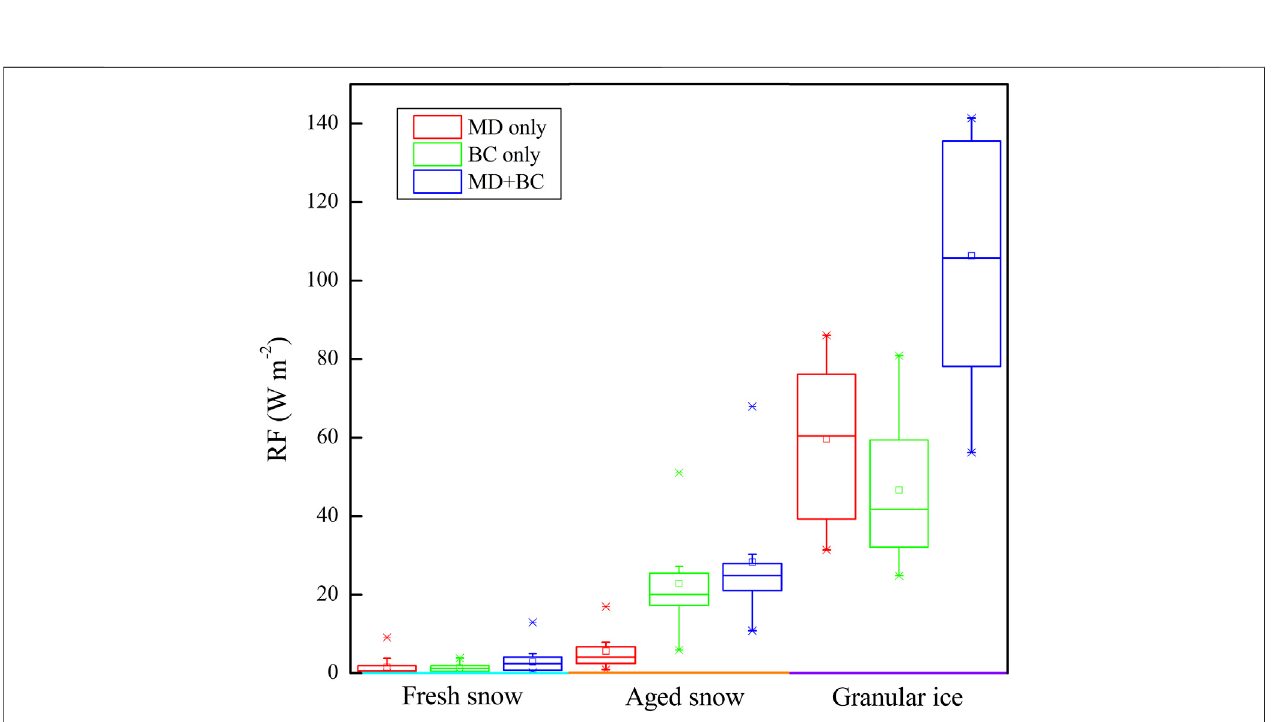
FIGURE 9 | The contribution of RF of BC and MD on Urumqi Glacier No.1 under three different melting conditions: fresh snow, aged snow, and granular ice.